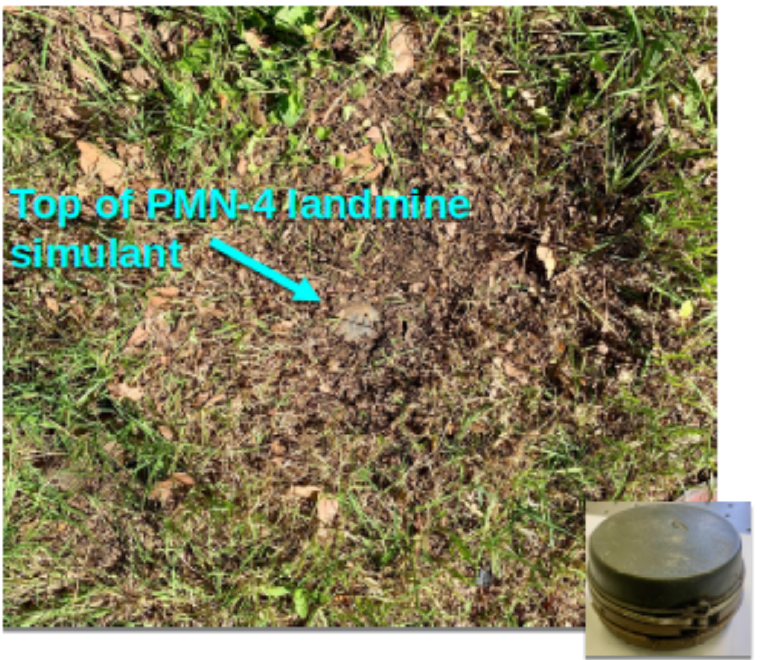
Figure 10. Image of PMN4 type landmine after acquisition. The over four-years-buried mine top is visible after removal of above terrain. Photo taken in the garden of the School of Engineering of University of